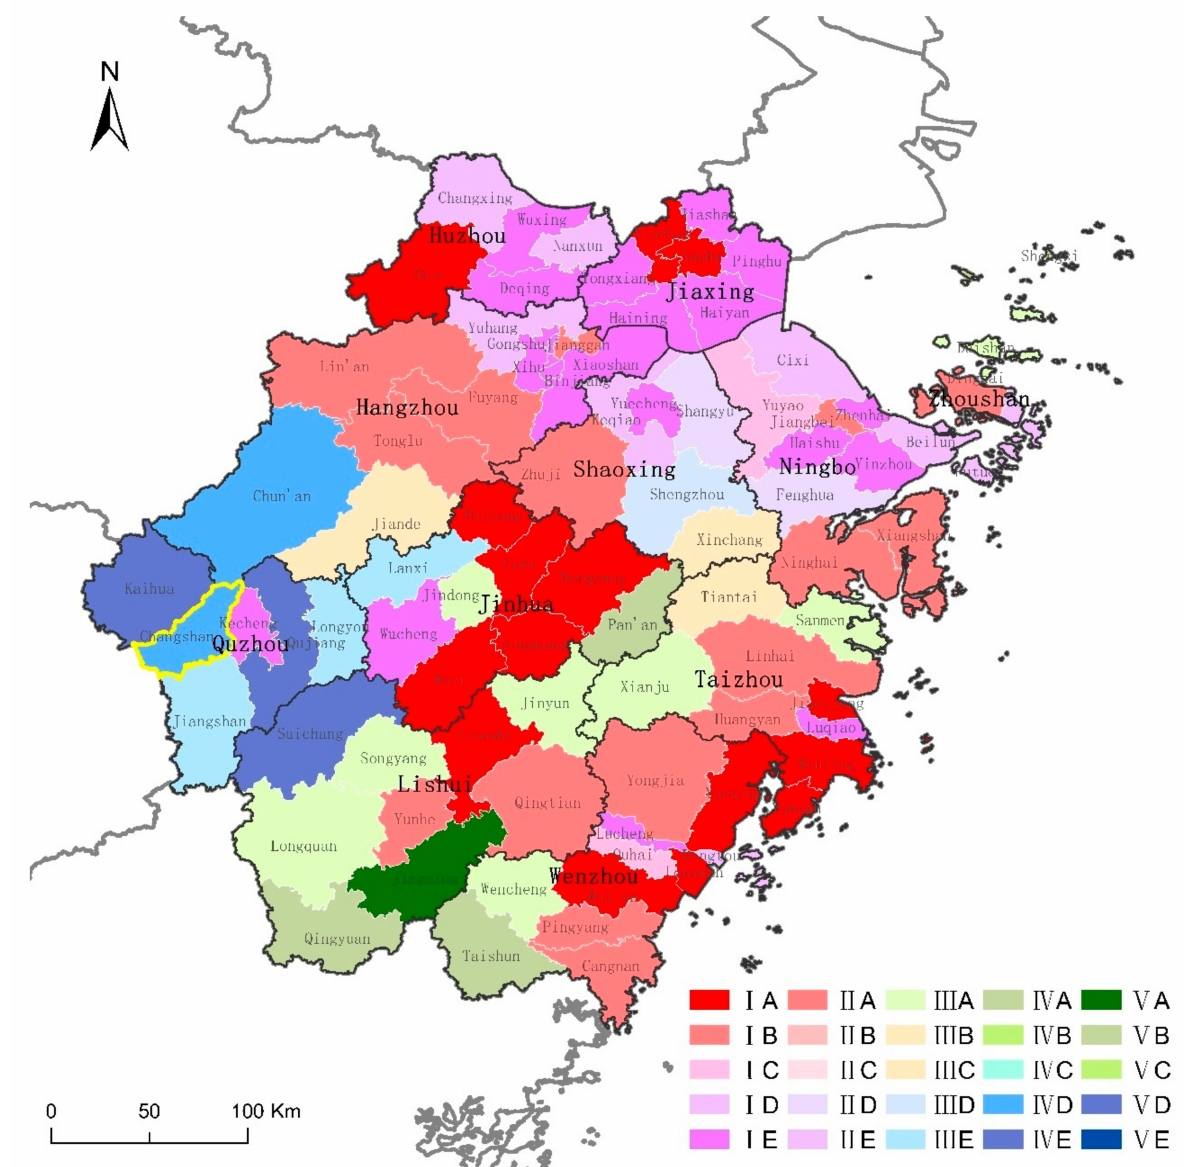
Figure 2. Changes in population and NTL intensity in Zhejiang Province county-level cities during